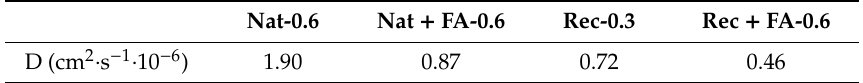
Table 4. Chloride diffusion coefficients at 20 °C.